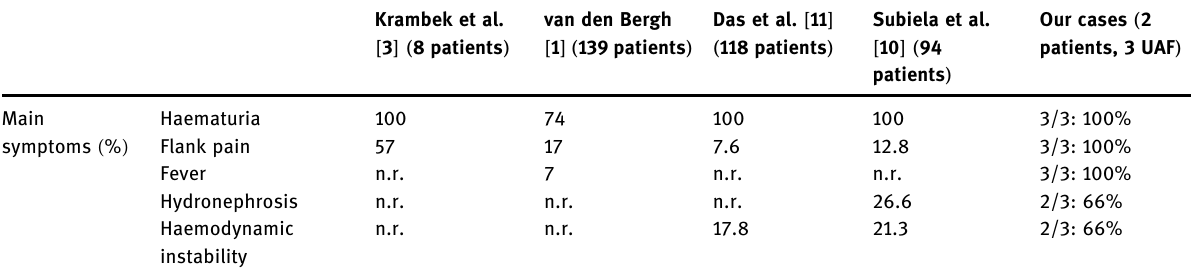
Table 3: The most common symptoms of UAF ( %